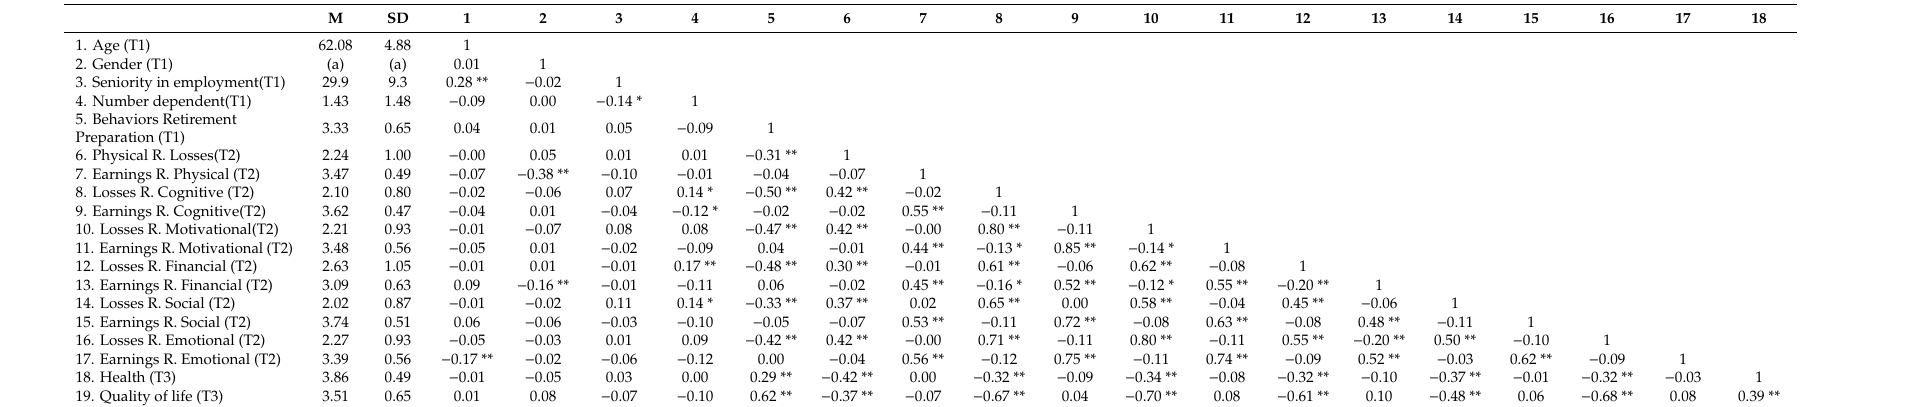
Table 1. Descriptive statistics and correlation matrix of the variables of the